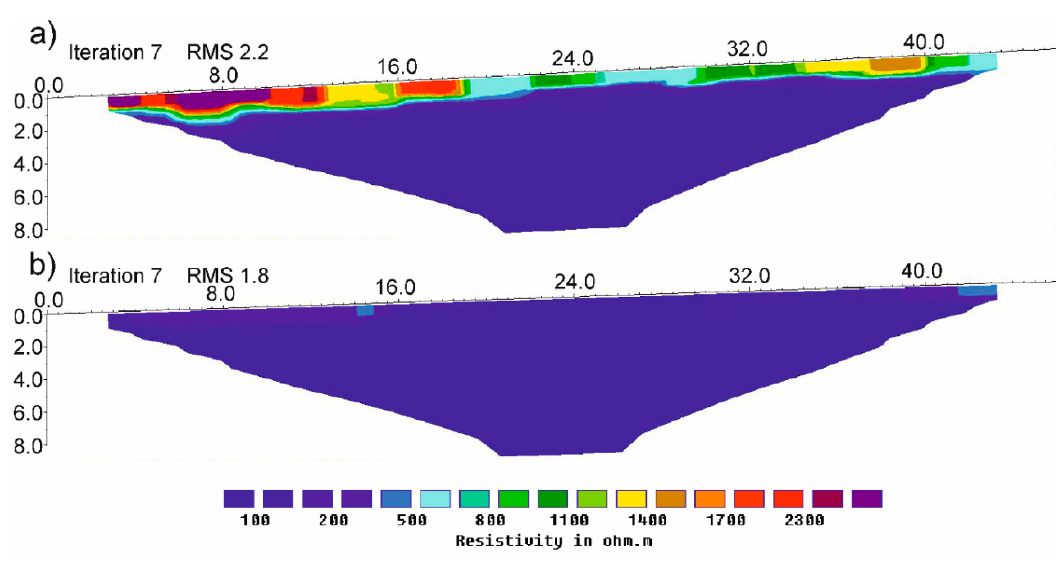
Figure 3. Apparent resistivity distribution on individual plots with concentrated uprooted trees: ( a ) the only plot with high resistivity, plot D6; ( b ) typical plot with low resistivity on plots with uprooted trees, plot H6.